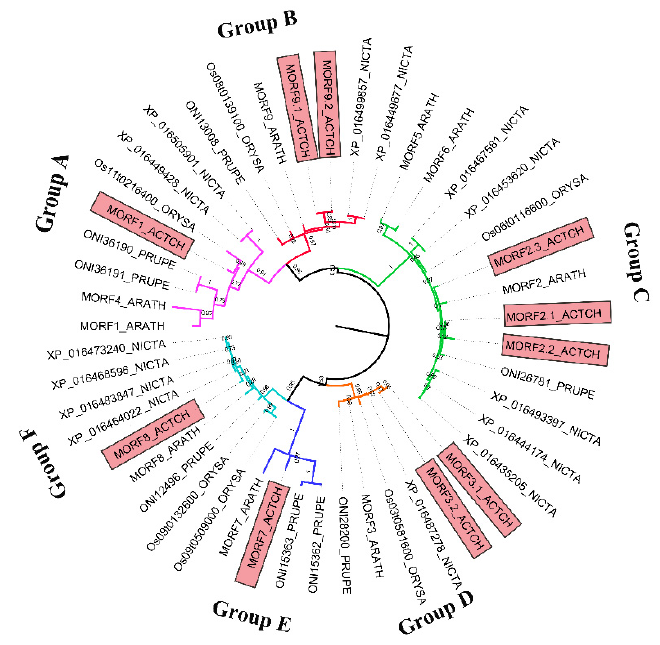
Figure 3. Phylogenetic relationships of the MORF gene family from kiwifruit, O. sativa , N. tabacum , A. thaliana , and P. persica . Forty-seven MORF genes were used for phylogenetic tree construction by the maximum likelihood (ML) method [27]. MORF genes in kiwifruit are indicated by red boxes, numbers on branches indicate the branch length. All the MORF genes were classified into six groups and designated as Groups A–F; branches from different groups are indicated by different colors.